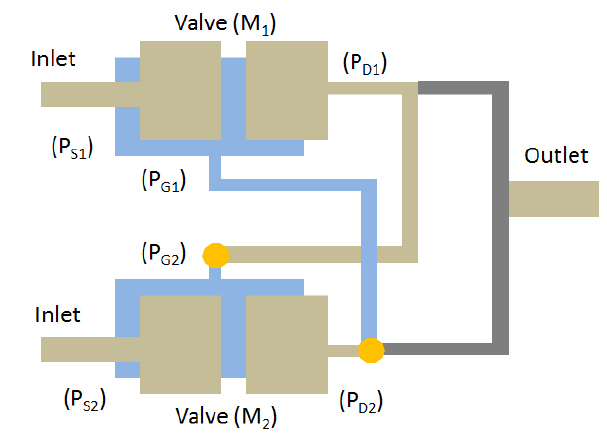
Figure 3. Interconnection of microvalve